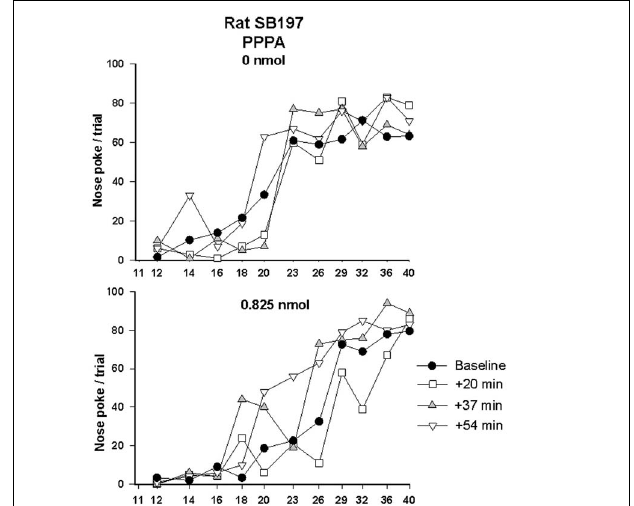
FIGURE 4 | Rate-frequency curves obtained from rat SB197 prior to (baseline) and injection of vehicle (top panel, 0nmol) and PPPA (0.825nmol/0.5 µ l/side). For clarity only four curves, including averaged baseline curves, are shown. The x -axis represents the number of pulses per train on a log scale.